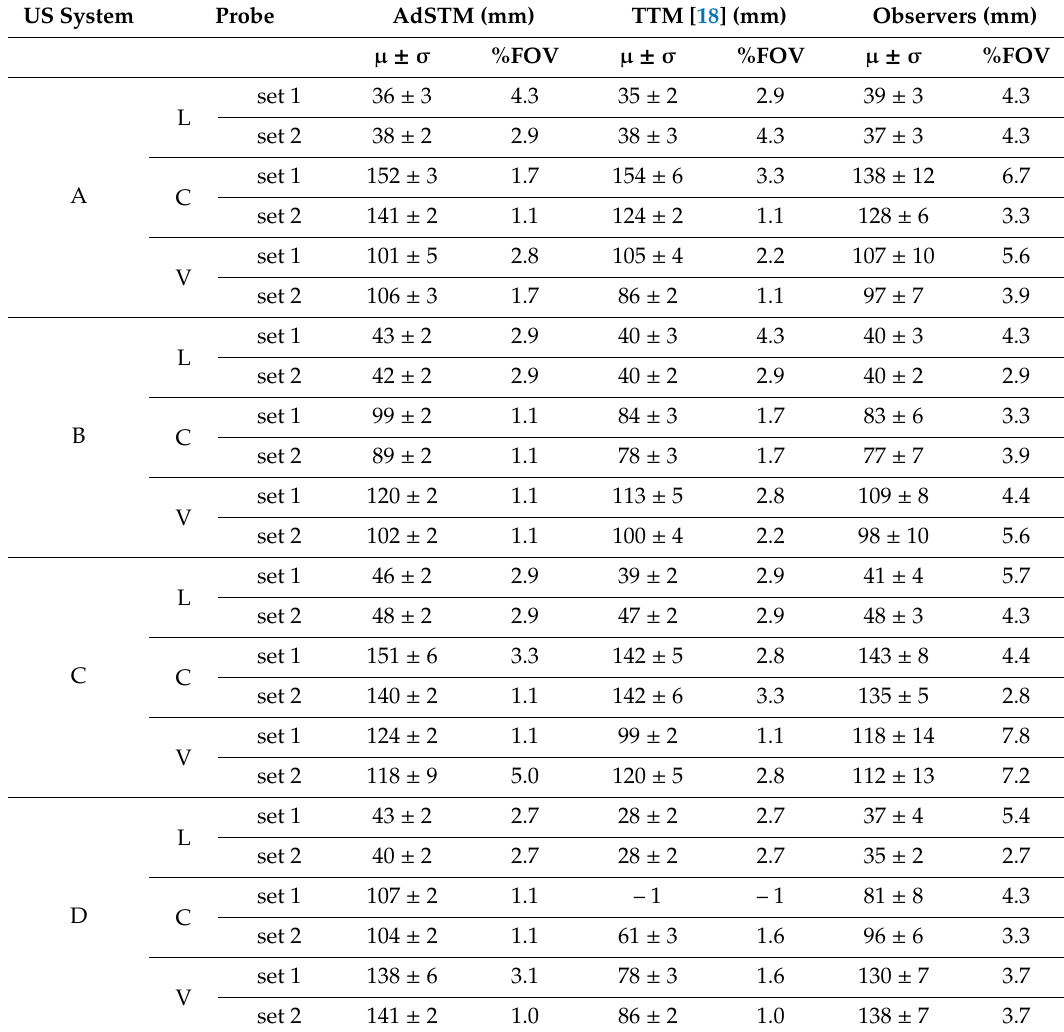
Table 4. DOP outcomes for di ff erent US diagnostic